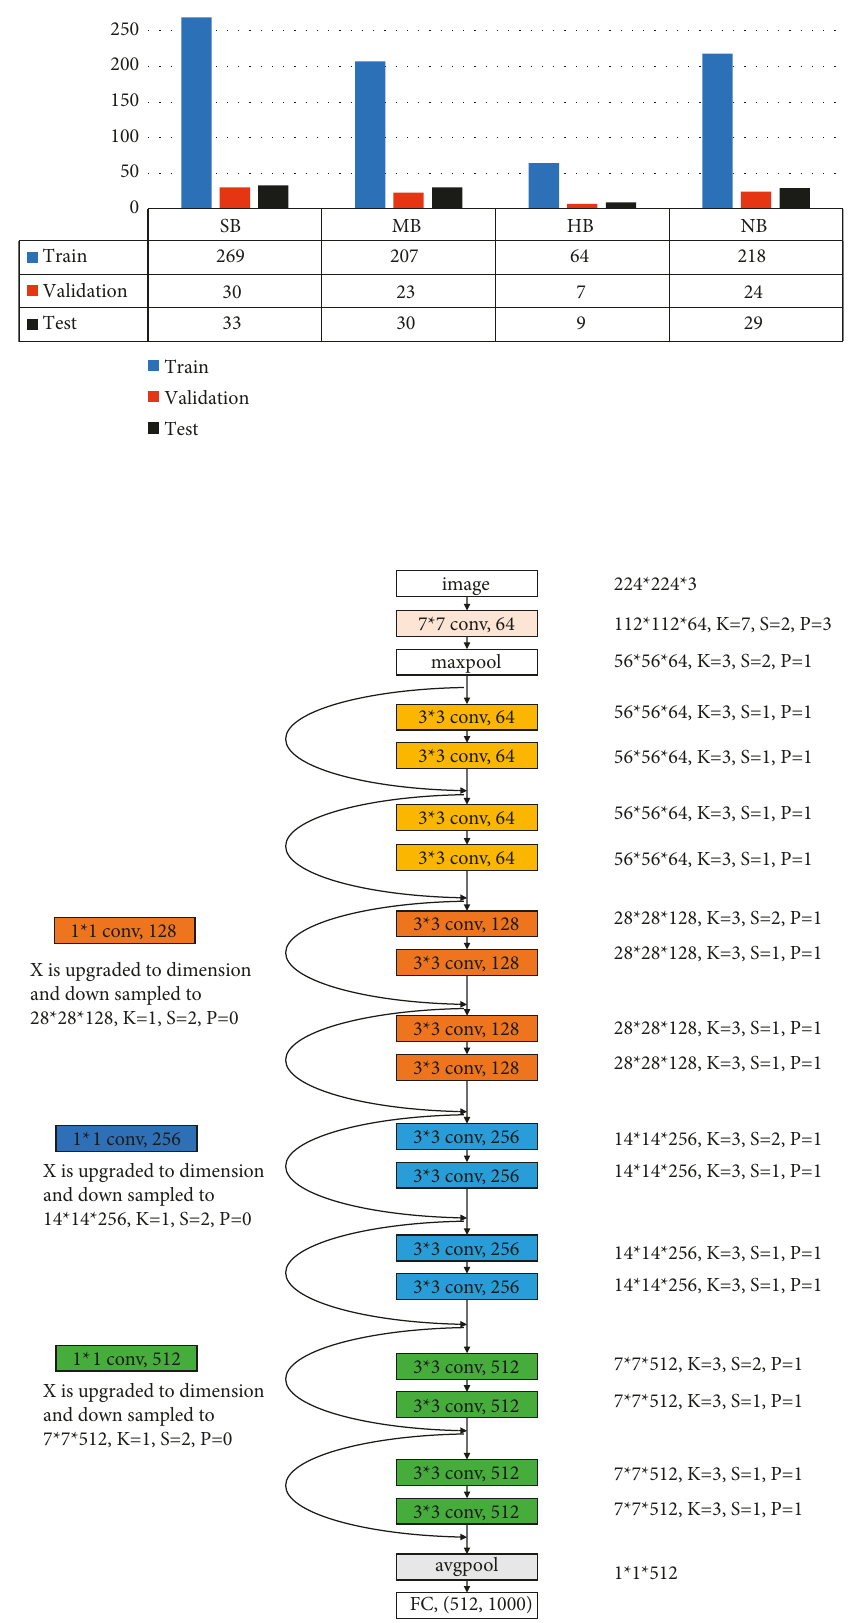
Figure 4: Network structure of the ResNet-18 model. Conv# � convolution; pool# � pooling; FC � full connection.